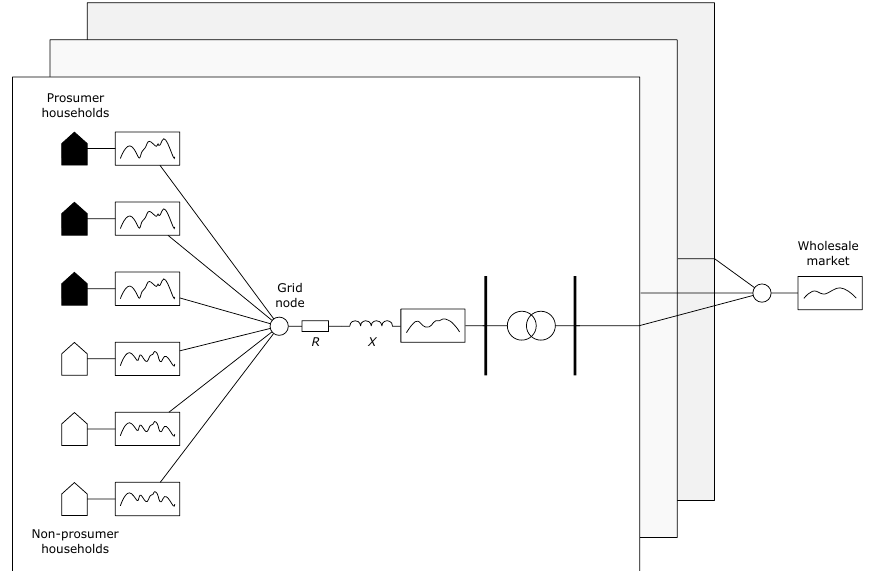
Figure 2. Schematic sketch of distribution network analysis. Sharp single-household load and production profiles from prosuming and consuming households result in smoothed residual load profiles on the distribution network node, taking into account simultaneity effects. Electrical energy is then further transferred via transformers to the transmission grid. Total supply and demand within the wholesale market zone exhibit further profile-smoothing portfolio effects.